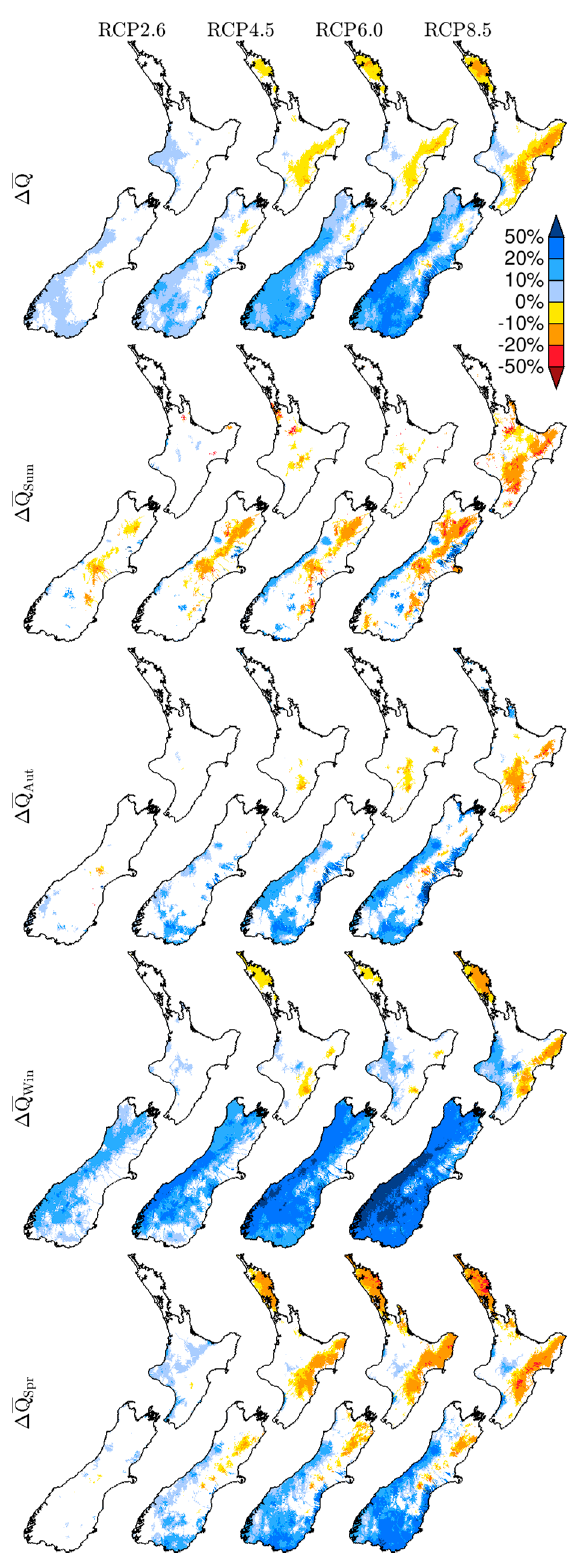
Figure 4. Late-century percentage changes in Q, Q Sum , Q Aut , Q Win , and Q Spr across four Representative Concentration Pathways (RCPs) relative to the reference period. White indicates statistically insignificant di ff